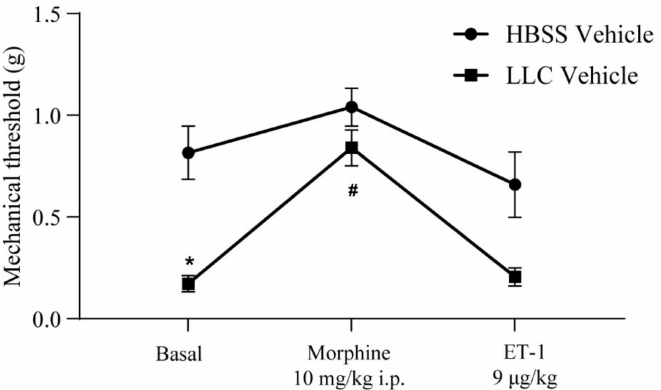
Figure 2. Assessment of mechanical pain thresholds in BTcP and control mice. Paw withdrawal thresholds in BTcP and control (HBSS) mice were recorded 10 min before i.p. injection of mor- phine (10 mg/kg), 20 min after morphine injection, and 5 min after intrafemoral injection of ET-1 (9 µ g/kg). Data are means ± SEMs of 10 mice per group. Two-way ANOVA for repeated mea- sures: HBSS vs. BTcP, F (1, 18) = 12.10; p = 0.0027; treatment, F (1.462, 26.31) = 37.51; p < 0.0001; interaction, F (2, 36) = 6.059; p = 0.0054. Sidak’s post hoc test p < 0.05 vs. the corresponding value of the HBSS group (*) or vs. basal and ET-1 value of the same group (#).